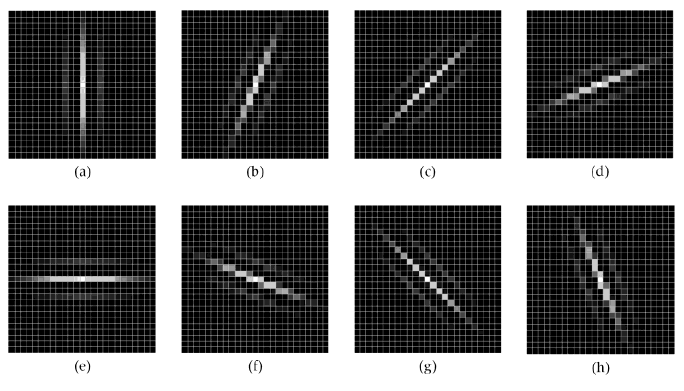
n π = n π , n = 0, 1, 2, . . . , θ n . Figure 2. ( a – h ) θ 8 8